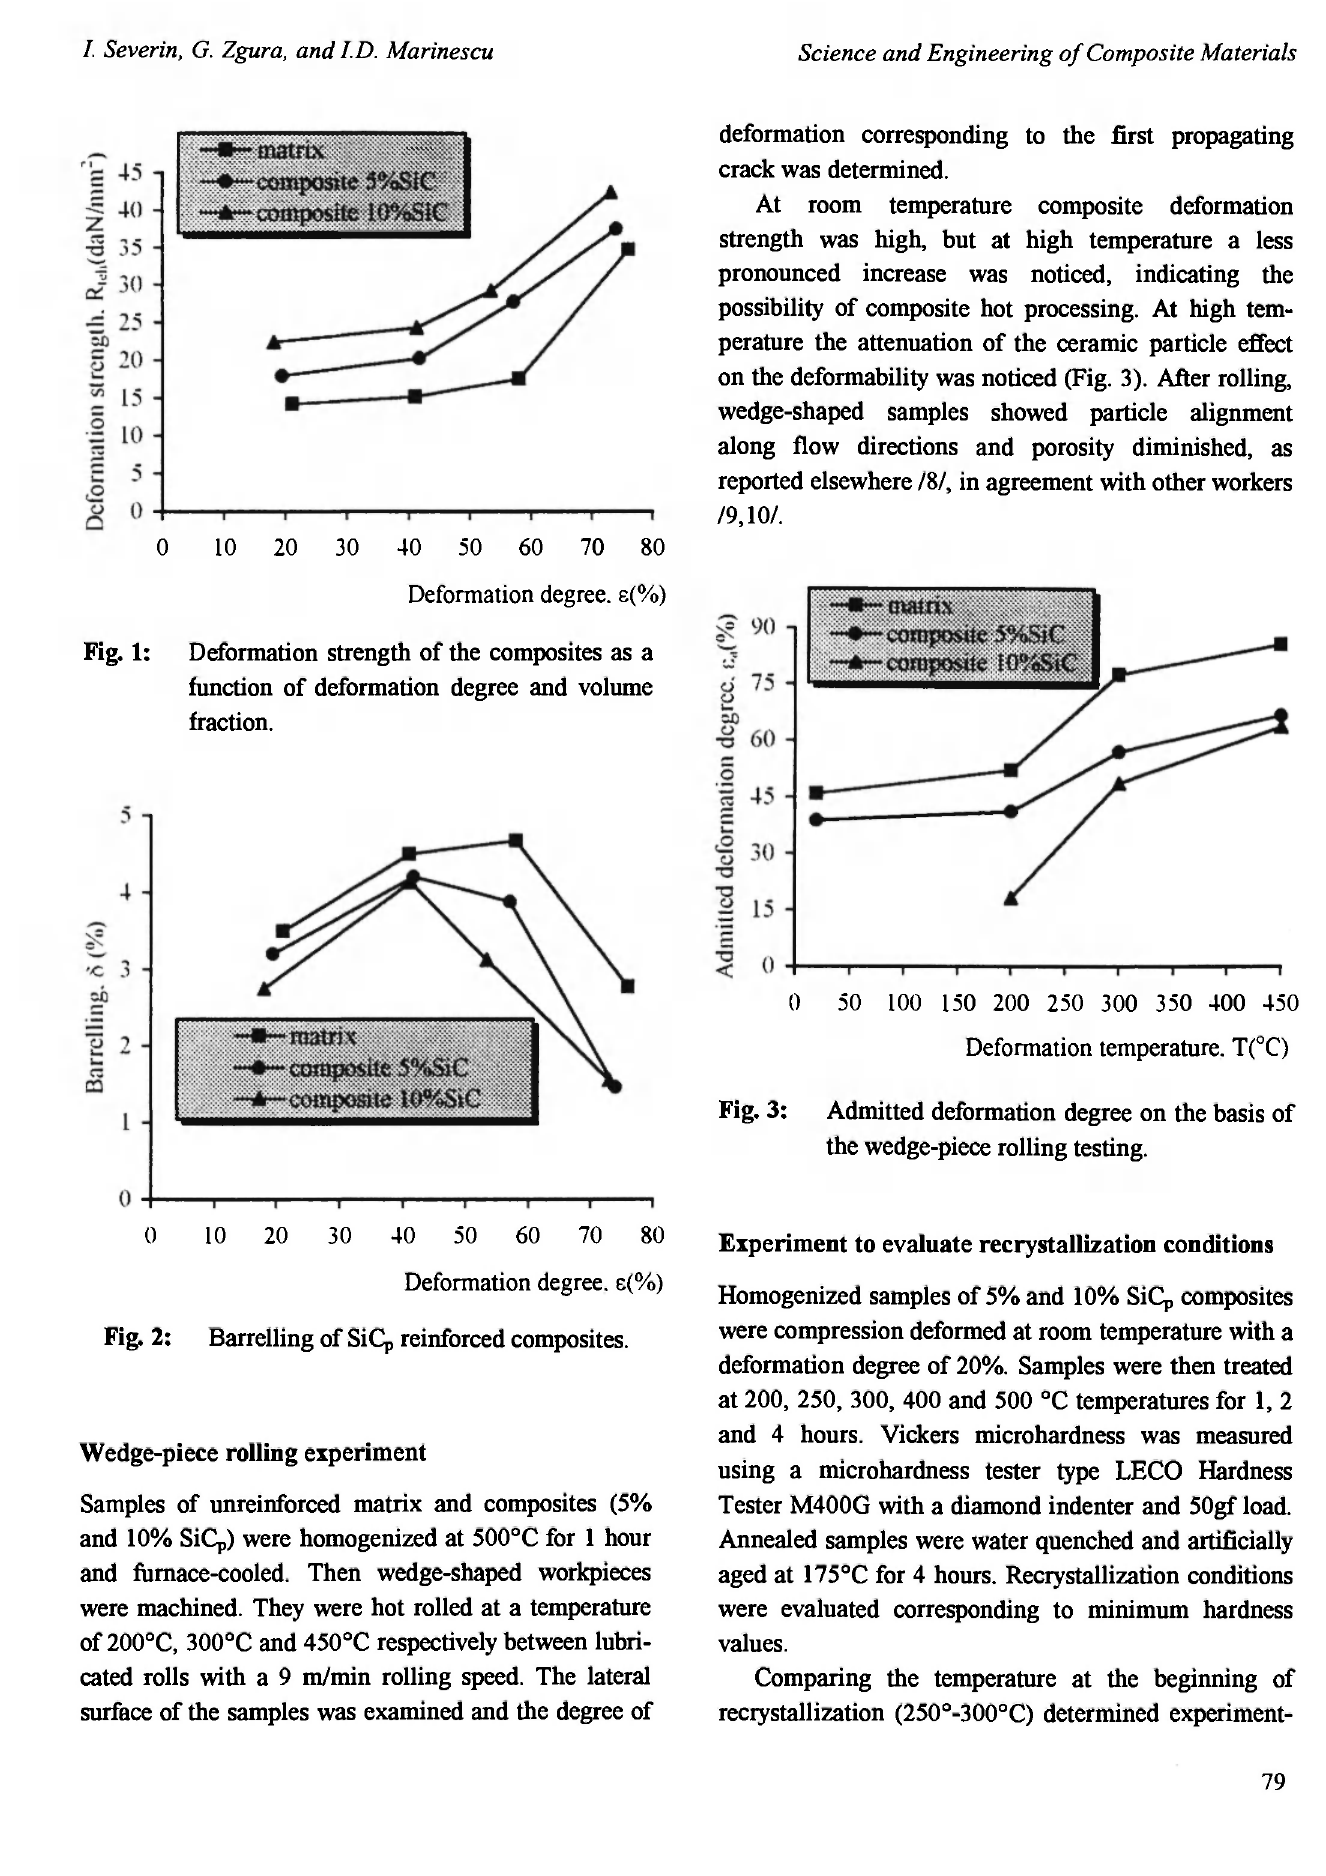
Experiment to evaluate recrystallization conditions Homogenized samples of 5% and 10% SiCp composites were compression deformed at room temperature with a deformation degree of 20%. Samples were then treated at 200, 250, 300, 400 and 500 °C temperatures for 1, 2 and 4 hours. Vickers microhardness was measured using a microhardness tester type LECO Hardness Tester M400G with a diamond indenter and 50gf load. Annealed samples were water quenched and artificially aged at 175°C for 4 hours. Recrystallization conditions were evaluated corresponding to minimum hardness values. Comparing the temperature at the beginning